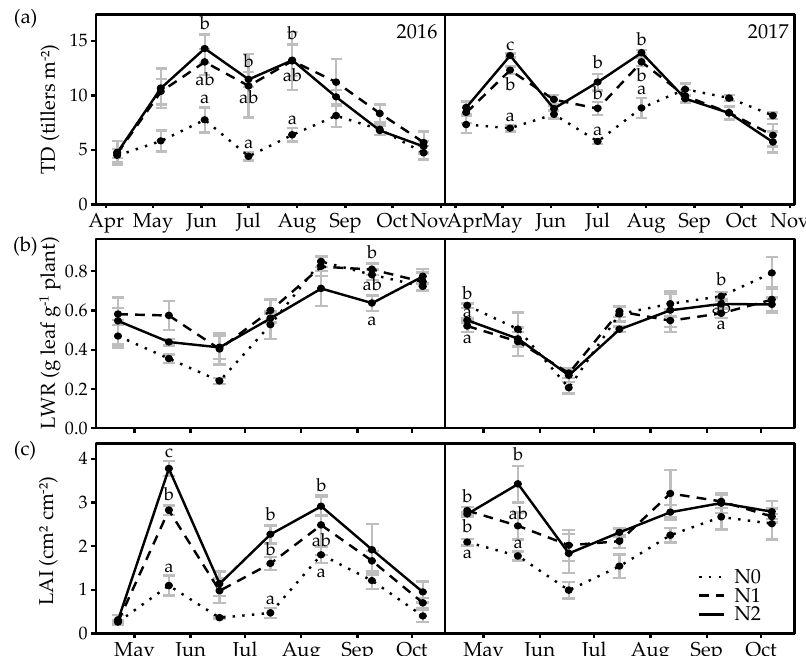
Figure 4. ( a ) Tiller density (TD), ( b ) leaf weight ratio (LWR) and ( c ) leaf area index (LAI) during the vegetation period of 2016 and 2017 for three N application rates (0 (N0), 140 (N1) and 280 (N2) kg N ha − 1 ). Mean values at the same date with different superscripts differ between N application rates ( p ≤ 0.05). Error bars show the standard error of the mean of the interaction between defoliation date and N application rate. SLA was lowest at the beginning of the vegetation period in both years (Figure 5a). g − 1 DM) ( p = 0.006) and in N1 and N2 compared to N0. In 2016, LNC m generally increased